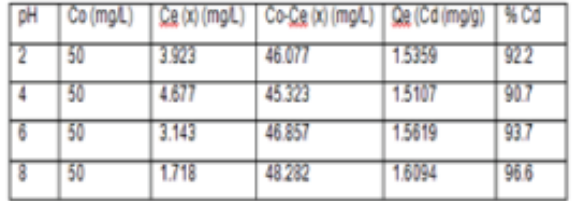
Table 1: Effect of pH on the removal of cadmium from aqueous solution